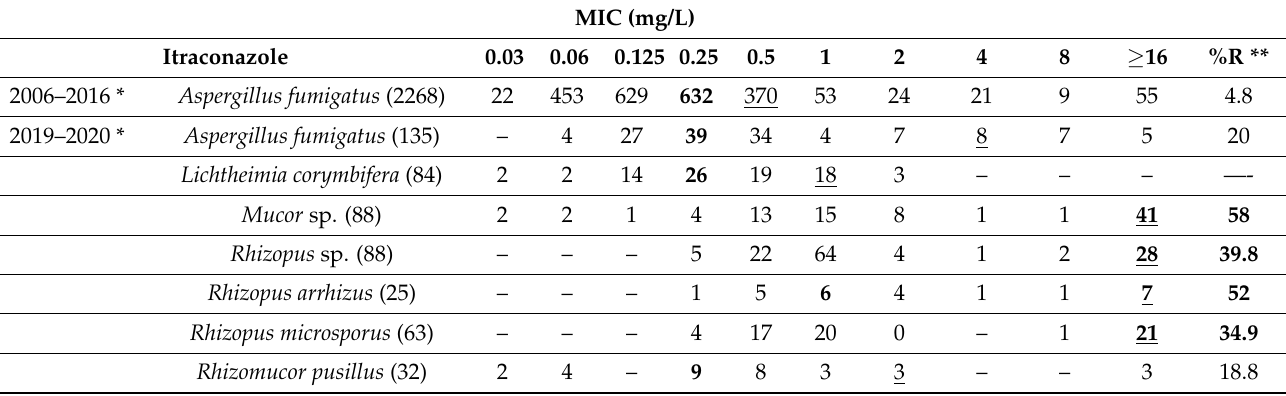
Table 3. MIC distributions for posaconazole. For presentation conventions, see Legend to Table 2.